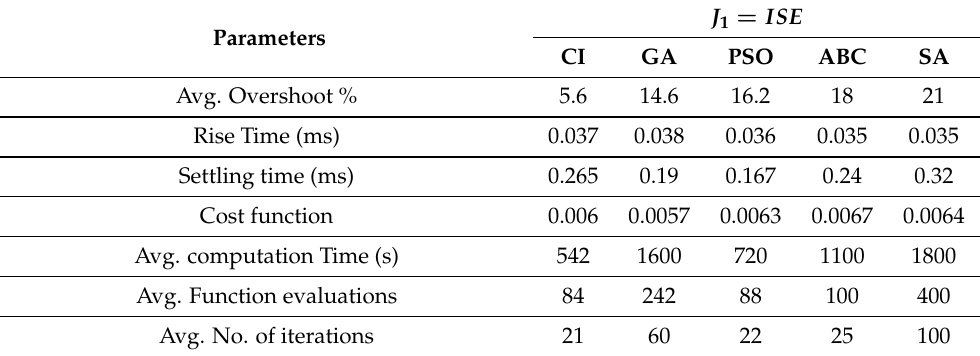
Table 4. Comparison of different optimization methods for the cost function